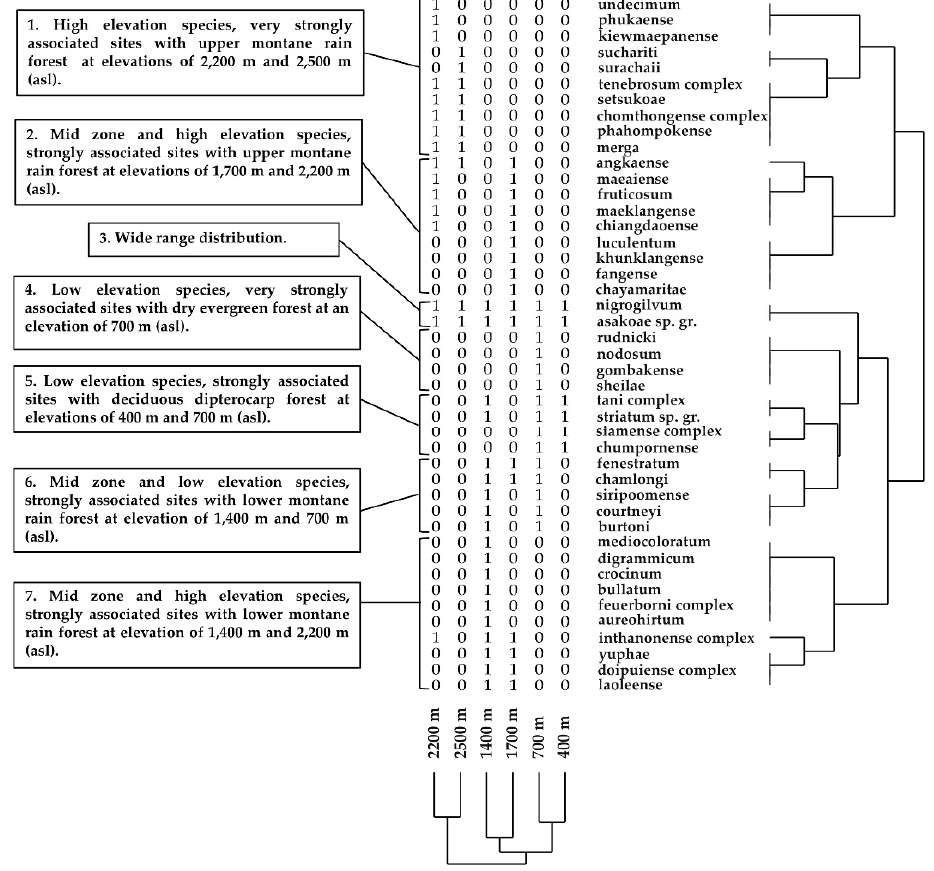
Figure 4. Cluster analysis using the Bray–Curtis resemblance coefficient and UPGMA to produce the dendrogram (Copen. Corr = 0.7728), based on species distribution along six elevational gradients in Doi Inthanon National Park.